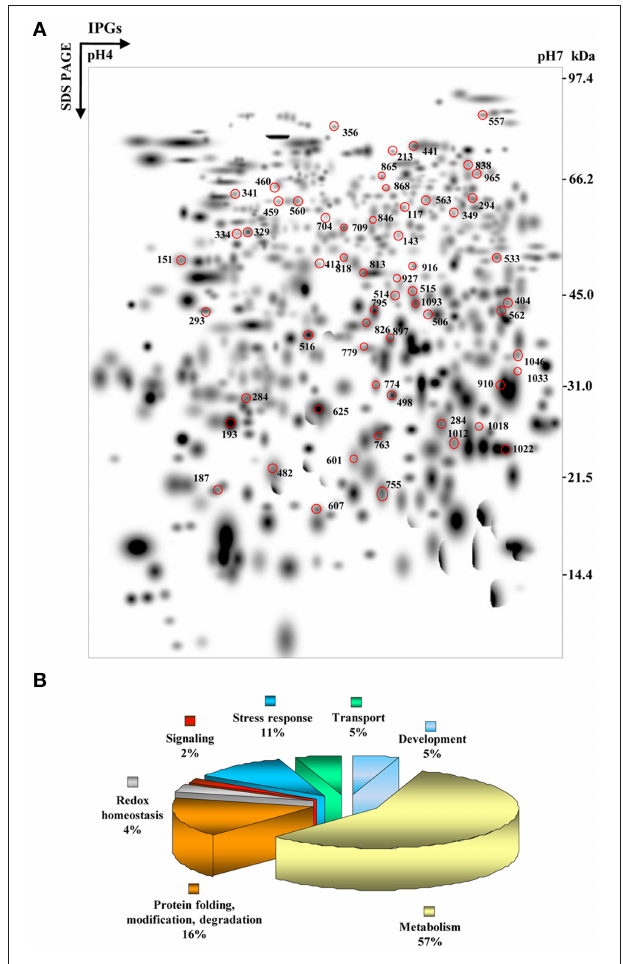
FIGURE 1 | Higher level match set and functional cataloging of PSRPs. (A) The match set was created in silico from three standard gels for each of the time points as depicted in Supplementary Figure S1. The numbers indicate spots listed in Supplementary Table S2 identified by MS/MS analysis. (B) Pie chart showing the functionally categorized